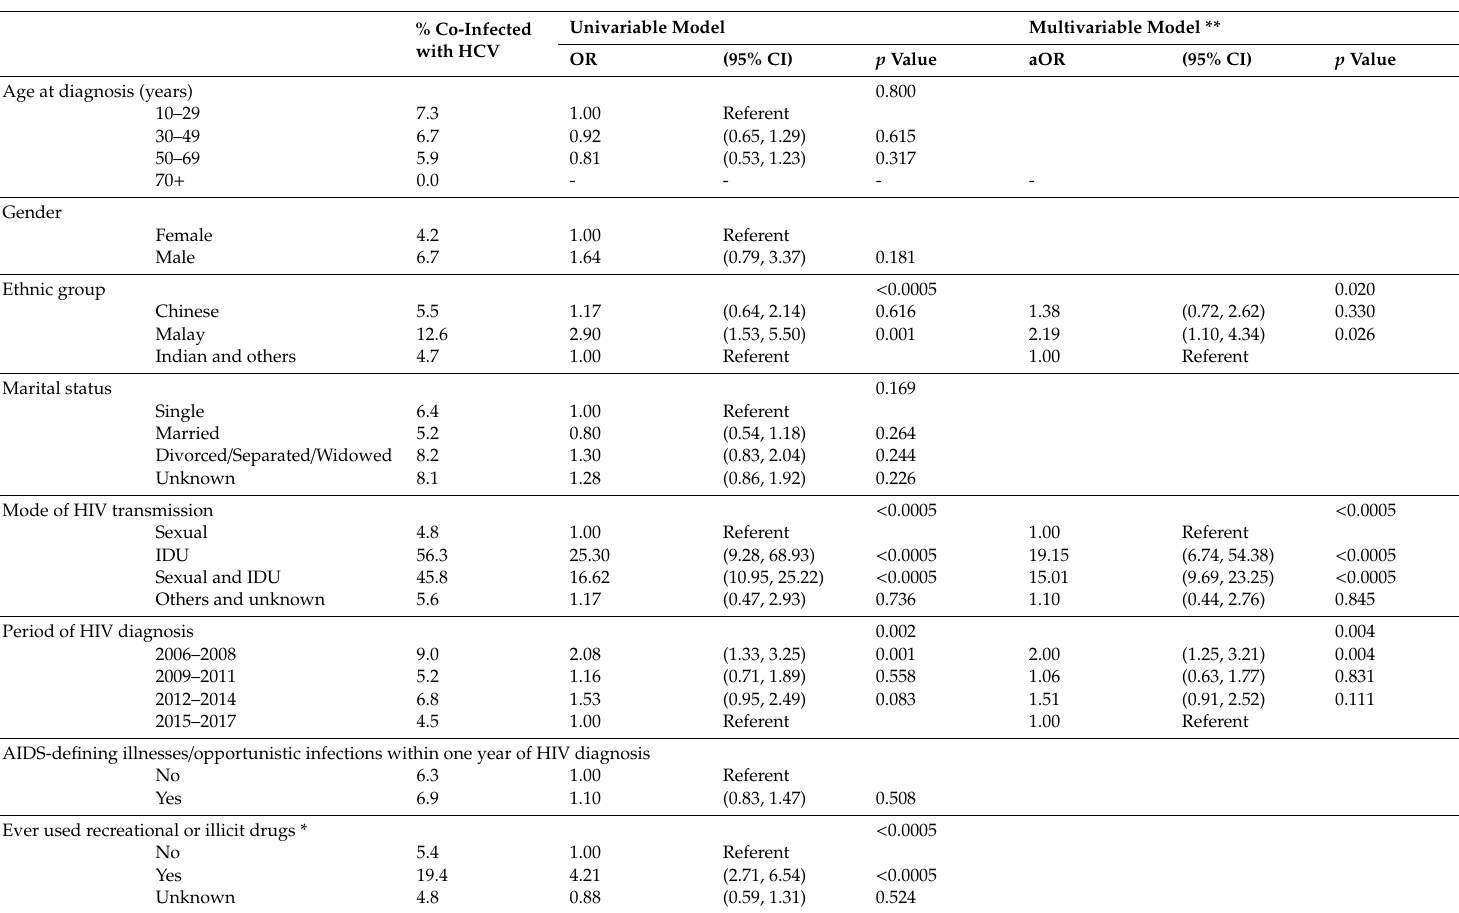
Table 4. Proportion and odds ratios of HCV co-infections in HIV-infected patients who attended the national referral centre for HIV in Singapore, 2006–2017. Univariable Model Multivariable Model % Co-Infected with HCV